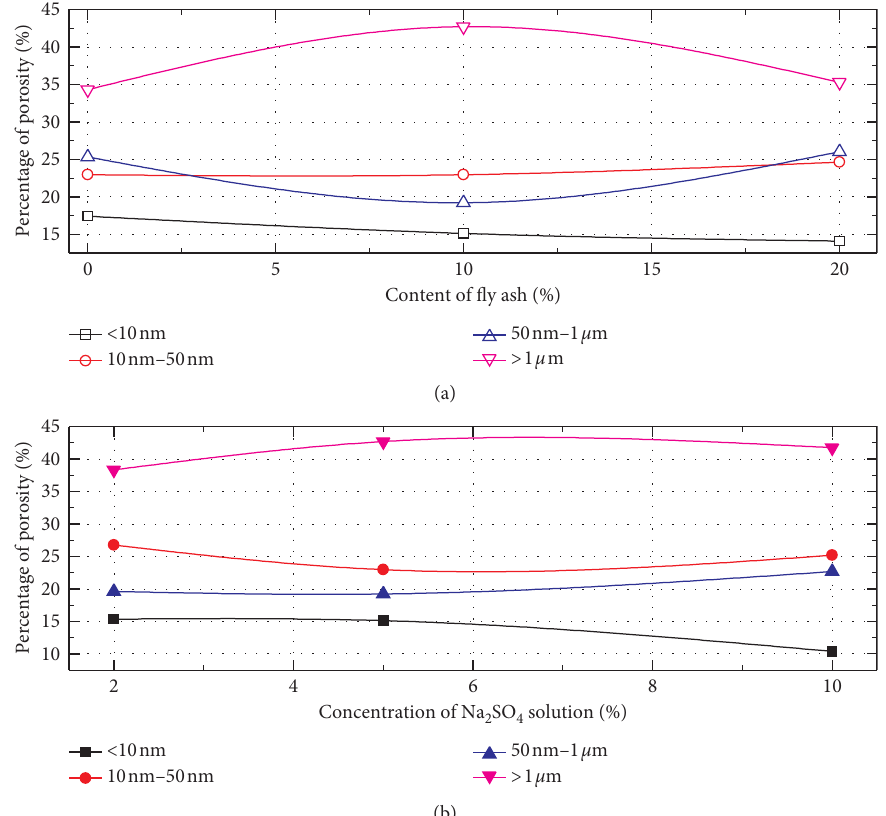
Figure 11: Relationship between pore size distribution and dosage of fly ash and salt solution.